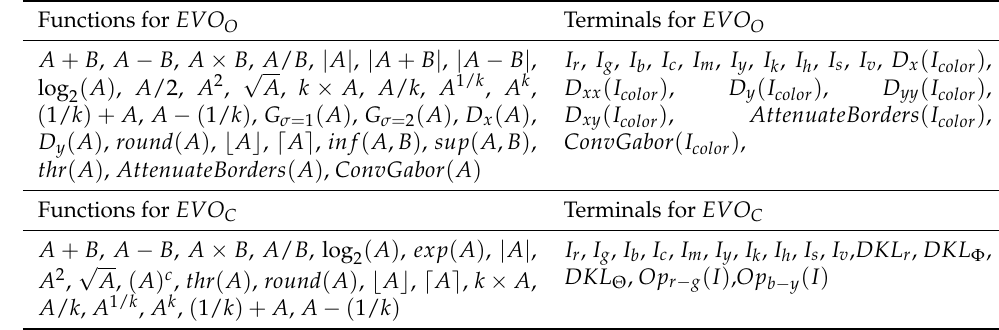
Table 1. Functions and terminals for the